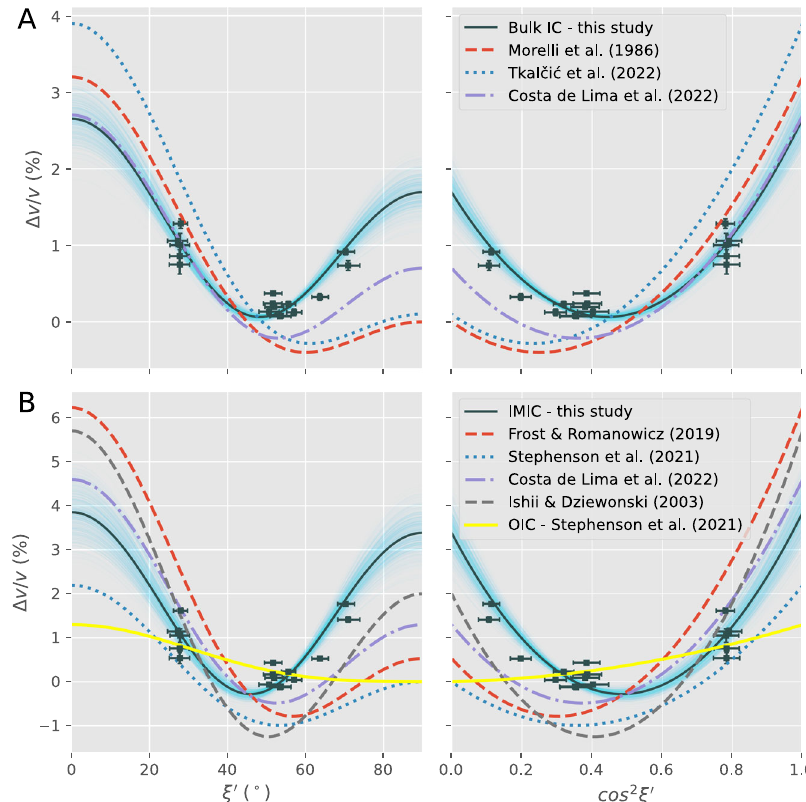
Fig. 3 | Cylindrically anisotropic model of Earth ’ s inner core (IC) inferred from exotic PKIKP multiples ’ travel times. Fractional velocity (see the Methods sec- tion) and fi tting curves are plotted as a function of ξ 0 , the representative sampling direction of the ray (left) (see Fig. 1), and cos 2 ξ 0 (right). All measured differential traveltimesarecorrectedformantleheterogeneitiesusingtheDETOX_P3model 49 . Associated uncertainties are plotted by error bars. Dark solid lines are the optimal anisotropic models parameterized in Eq. 1, and light blue opaque lines represent